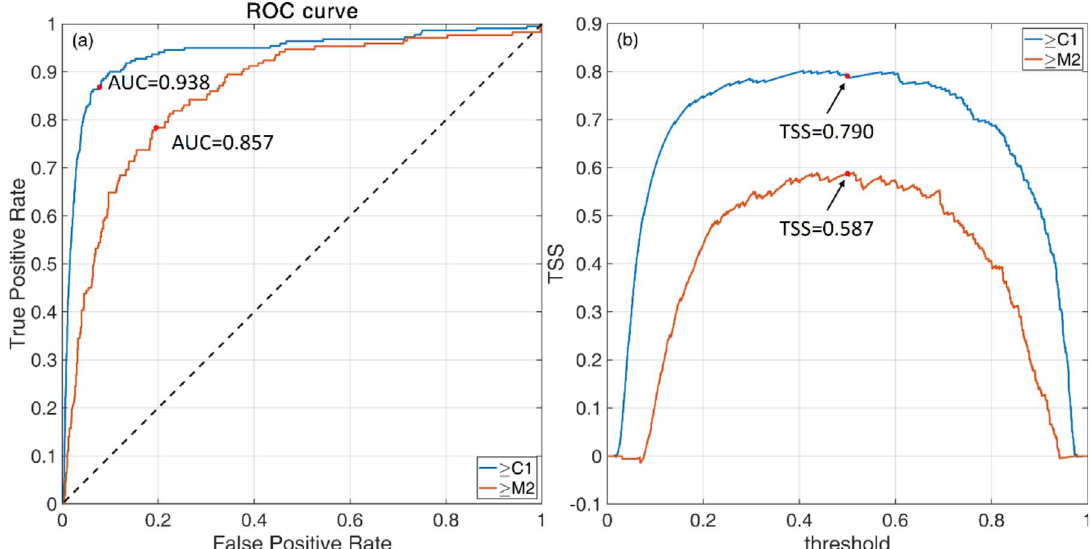
Fig. 7. (a) The ROC curve derived from the probabilistic outputs of the model showing the relation of true positive rates and false-positive rates for all thresholds values 2 [0, 1]. Two curves are shown for both the SF (cid:1) C1 and SF (cid:1) M2 cases. The dashed line denotes the random classi fi er behaviour. (b) Evolution of the TSS score for the same range of applied thresholds. Red circles mark the points for a threshold equal to